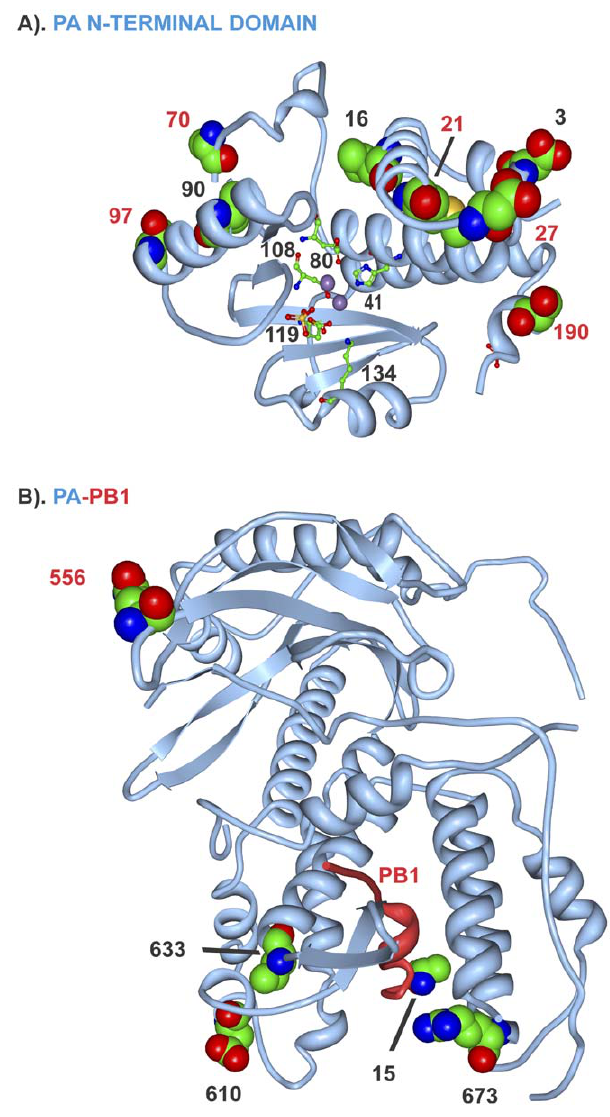
Figure 4. Mouse adaptive mutations on PA and PB1 three dimensional maps. Images are shown as in Fig. 3. A) PA N-terminal domain with nuclease site active residues, H41, E80, D108, E119 and K134 shown in stick diagram; manganese ions are shown with purple spheres. (B) PA (blue) PB1 (red) complex; PA amino acids 1–14 are in direct contact with